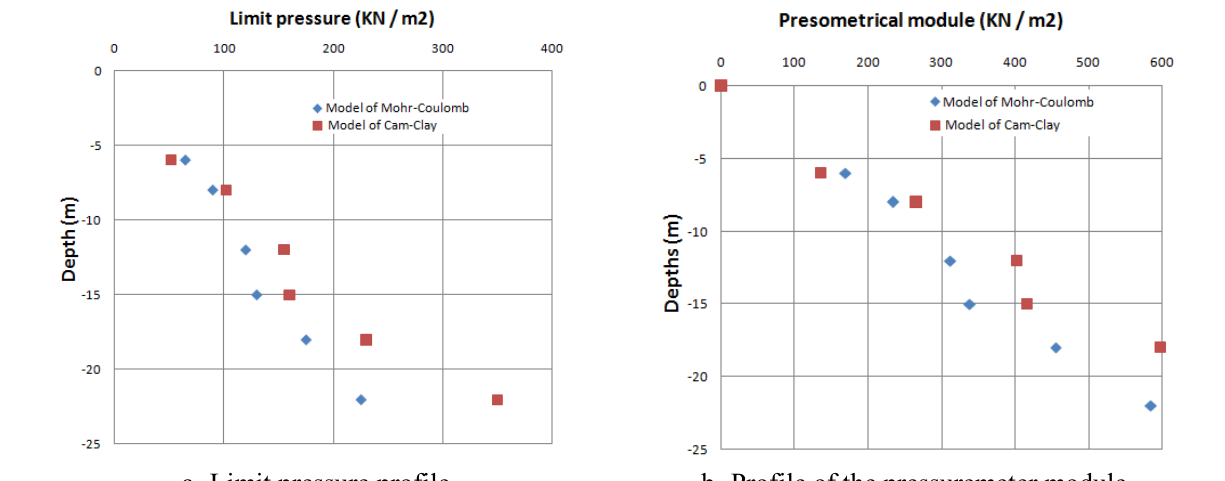
Fig.5. Profiles of pressuremeter